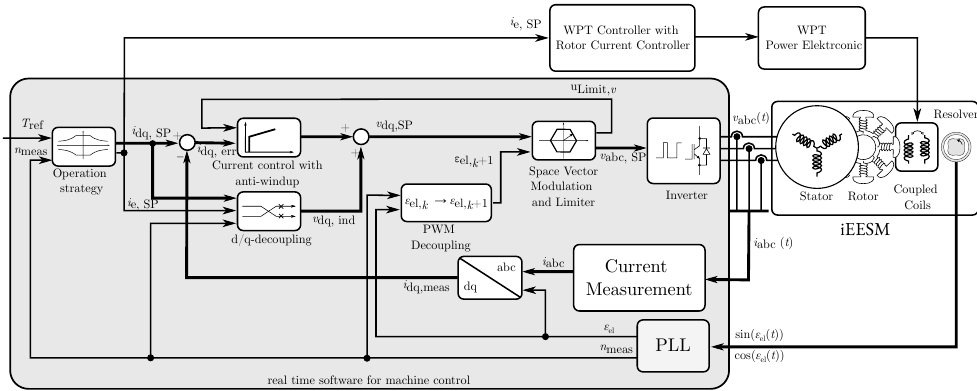
Figure 15. Real-time software for machine control (highlighted in gray) with in- and outputs. Big arrows are vectors with multiple signals; small arrows show single